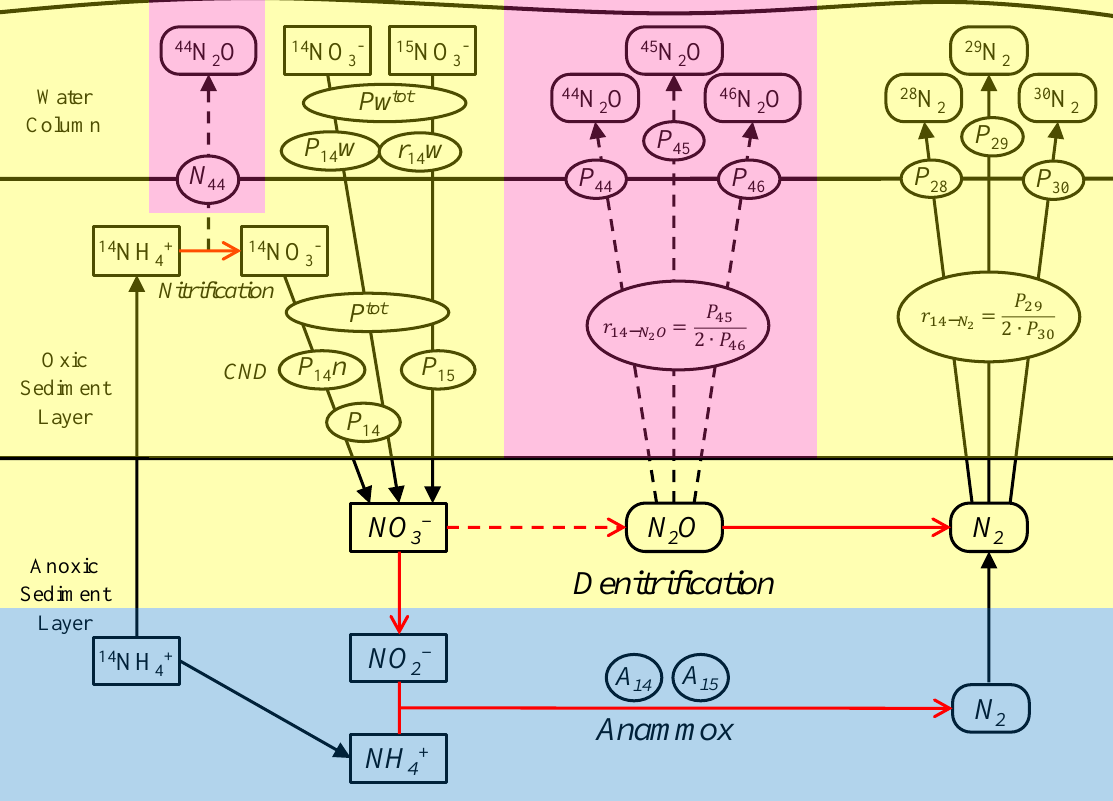
Fig. 1. Schematic diagram of various N transformation processes and rates considered by different versions of IPT (after ref. 11). Yellow Figure 1. Schematic diagram of various N transformation processes and rates 897 plate represents IPT classic . Yellow and blue plates represent IPT ana . Yellow and pink plates represent IPT N IPT anaN . Gases isotopic N 2 and/or N 2 O production rates in individual process are designated, respectively, as “ P x ” or “ A x ” (e.g., P 14 2 O considered by different versions of IPT (after ref. 11). Yellow plate represents 898 . Yellow and blue plates represent IPT IPT classic IPT . Full diagram represent IPT N 2 O rates in individual process are designated by “ P N/m 2 /h). Detailed explanation of the abbreviations is given in Table 1. The equations 902 of r and r represent the ratio between using 14 NO 3- and 15 NO 3- during nitrate 903 14-N 2 14-N 2 O reduction in different estimators. CND is the process of coupled nitrification 904 denitrification. 905